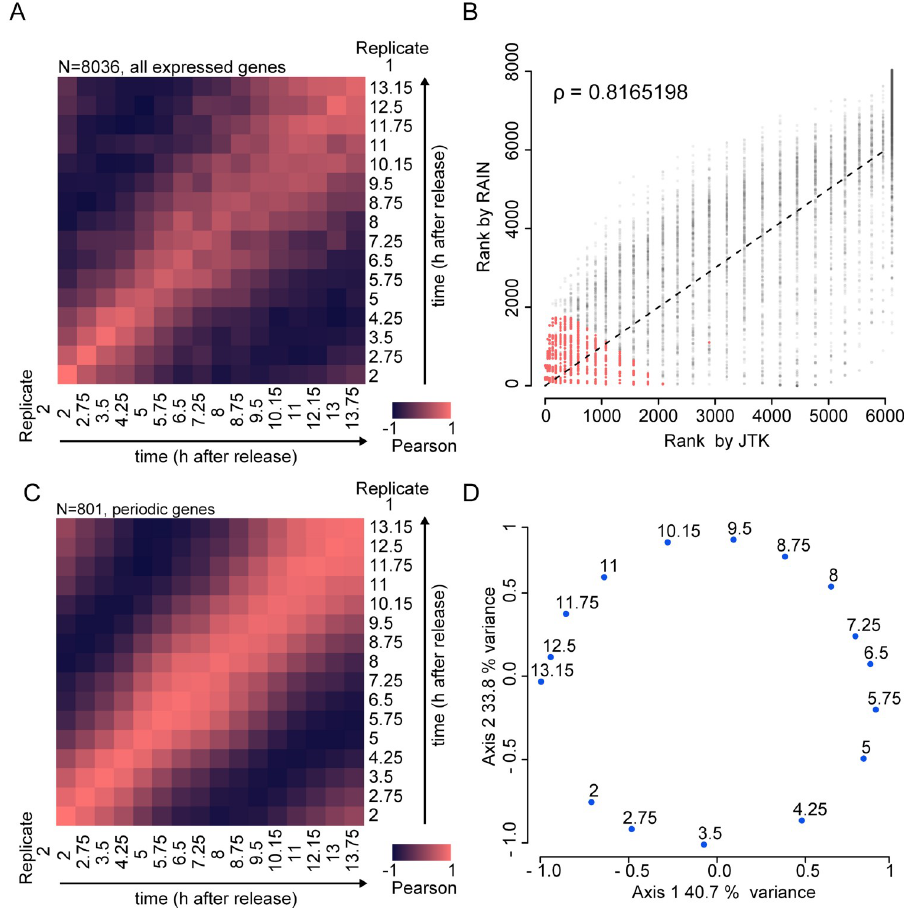
Fig 3. Detection of periodic genes in Capsaspora . A : Pearson correlation for the normalized expression level of every gene between replicates. Bright red indicates positive correlation, and dark purple indicates negative correlation. B : Spearman correlation between the two methods used to detect cell cycle regulated genes in Capsaspora . Scatter plots depicting the rank assigned for every gene by the JTK_CYCLE and RAIN on an average dataset of the two time-series replicates. These two algorithms rely on different approaches to finally assign, for every gene, a p-value interpreted as the probability that it can be considered periodic. For its proper functioning, we set the two algorithms to look for periodic behavior in a lapse of 11 to 13 hours, with time lapses of 0.75 hours. We assigned two ranks to every gene according to the p-values calculated by JTK_CYCLE and RAIN. Each dot represents a gene expressed in the time series. Colored dots represent the 801 genes that were finally taken as periodic according to our criteria. C : Pearson correlation for the top 801 cell cycle regulated genes, also based on normalized gene expression level. See Fig 4 for more details. D : Principal coordinate analysis on the set of 801 cell cycle regulated genes based on normalized gene expression level. Every dot represents a time point in the experiment.